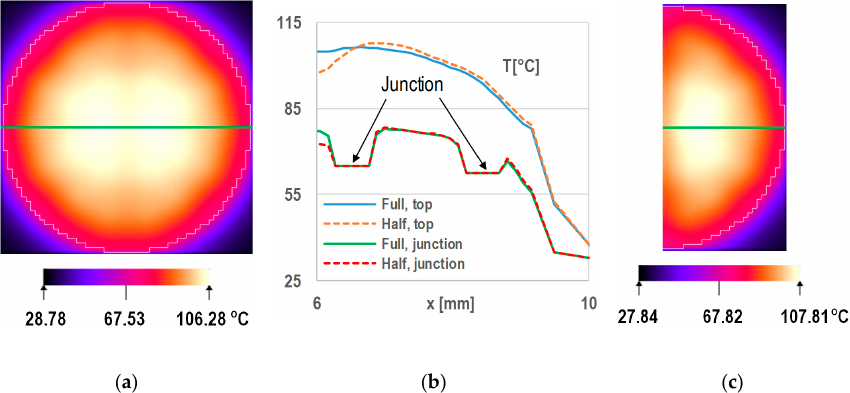
Figure 25. Simulated distributions of the temperature rise (model setup: 400 mA driving current, 25 °C ambient temperature, light propagation described by model g) presented in Section 5.1, with equal blue and yellow absorption, 90% importance level) ( a ) surface temperatures: full model; ( b ) cross-sectional plots of temperature distributions at the blue chip junctions and at the top surface along the green lines; ( c ) surface temperatures: half model.